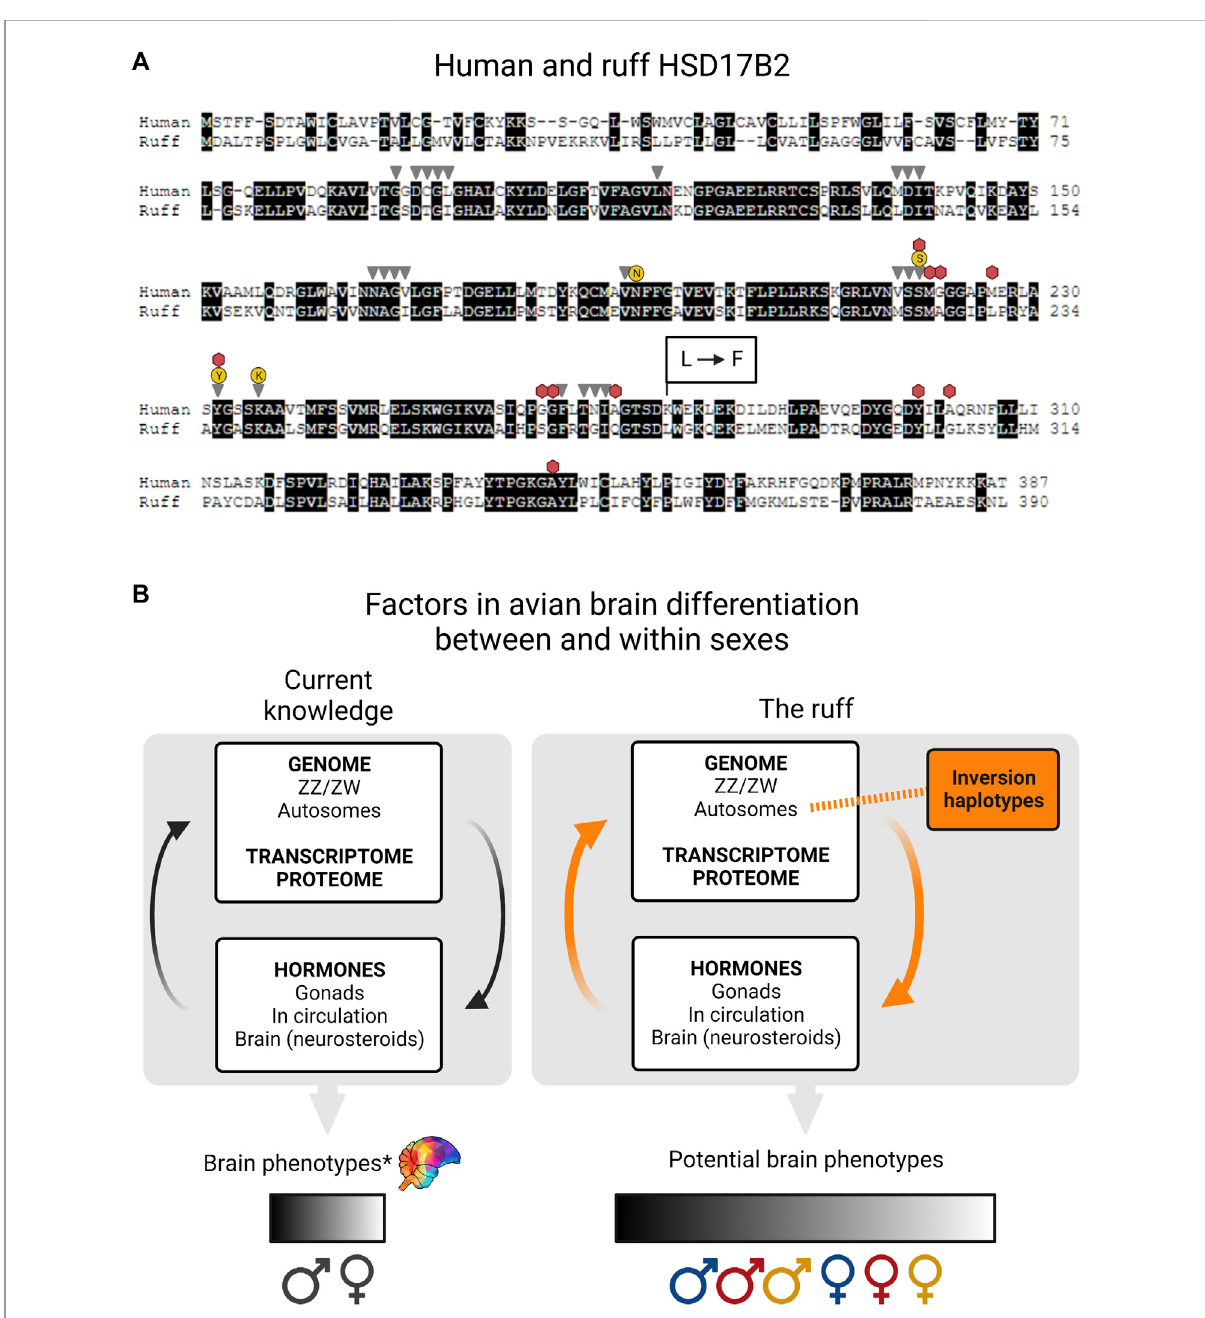
FIGURE 2 Missense mutation in ruff HSD17B2 and factors in avian brain differentiation. (A) Pairwise alignment of human and ruff HSD17B2 proteins (accessionnumbersNP_002144.1,XP_014797711.1)(BLOSUM45matrix,internalgappenalty=-4)withidenticalresiduesinablackbackground).The 37 residues belonging to the HSD17beta type 2 conserved domain are indicated for NADP binding (gray triangles), steroid binding (red hexagons), catalytic tetrad (yellow circles). At ruff position 279, Satellite and Faeder alleles have the missense mutation that changes leucine to phenylalanine, indicated by L → F. Amino acid changes at this same position in the human protein increase catalytic activity for testosterone to androstenedione up to 5-fold compared to the non-mutated version (Sager et al., 2021). (B) The current knowledge of avian brain differentiation between and within the sexes relies on a series of complex interactions and here we show a simpli fi ed illustration of key factors: the genome, transcriptome, proteome and hormones. Sex chromosomes express speci fi c genes that help determine gonadal sex, which in turn provides a hormonal environment from the synthesis of sex steroids from gonadal tissues. Sex hormones have a major effect on sexual differentiation. Once bound to receptors (i.e. androgen and estrogen receptors) these will then act as transcription factors and regulate the expression of target genes throughout the entire genome. Autosomes allow the expression of receptor genes to sense hormones and enzymes that can make hormones, includinginside braincells(neurosteroids).e.g.byaromatizingcirculatingtestosteroneintoestradiol.All oftheseprocessescontributetovariation in